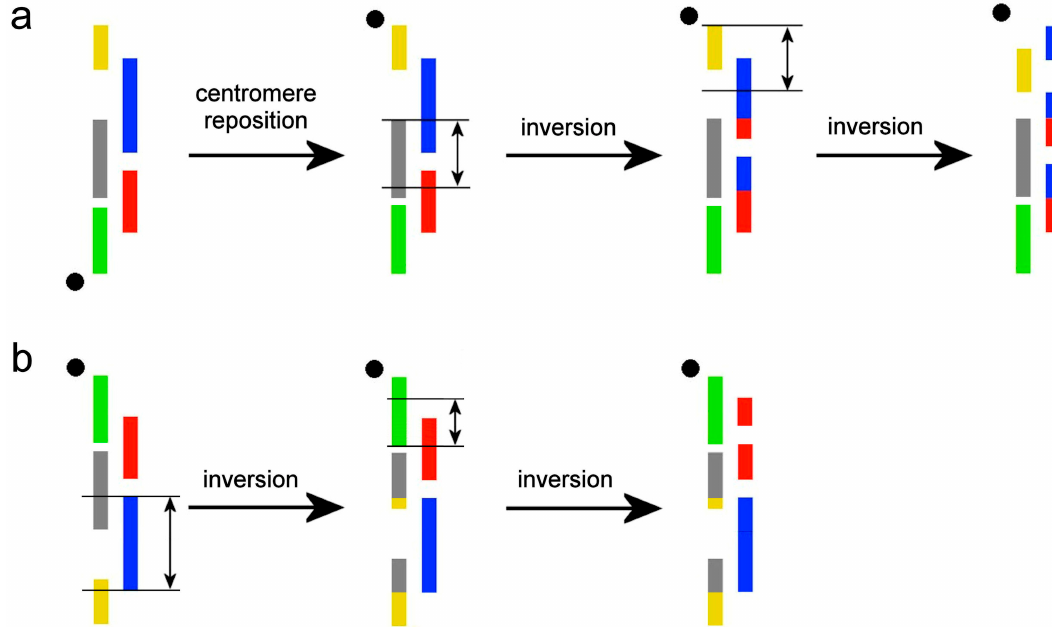
Figure 3. A putative scheme for intrachromosomal rearrangements ( a ) in the q-arm of M. arvalis chromosome 2; ( b ) in M. rutilus chromosome 3. The black circles mark the position of the centromere. The black lines and vertical arrows mark the regions of inversions. The colors of the microdissection-derived probes correspond to those on Figure 1.